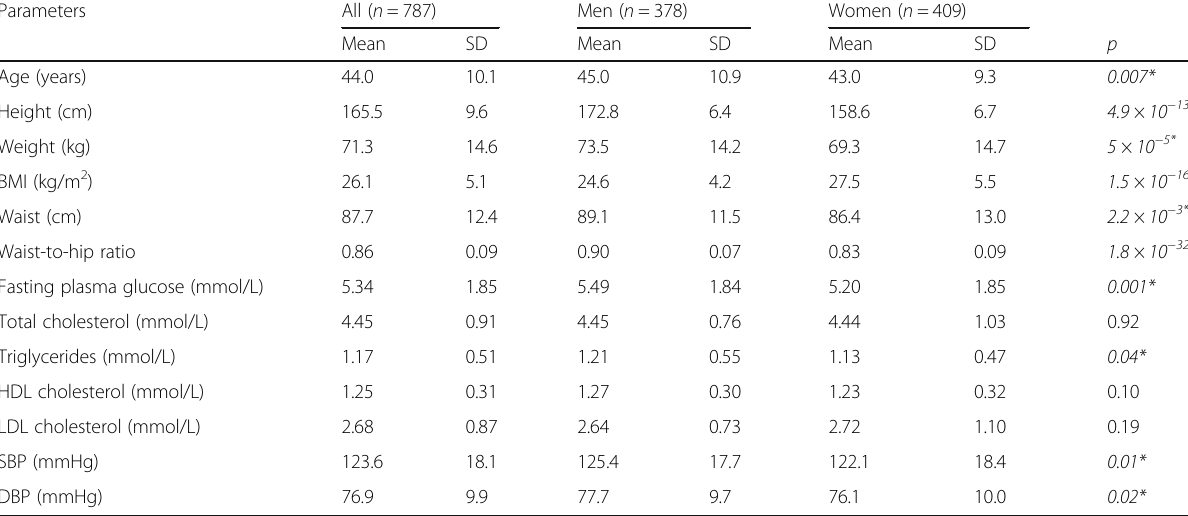
Table 1 Anthropometric, biochemical, and clinical characteristics of the genotyped subjects Parameters All ( n =